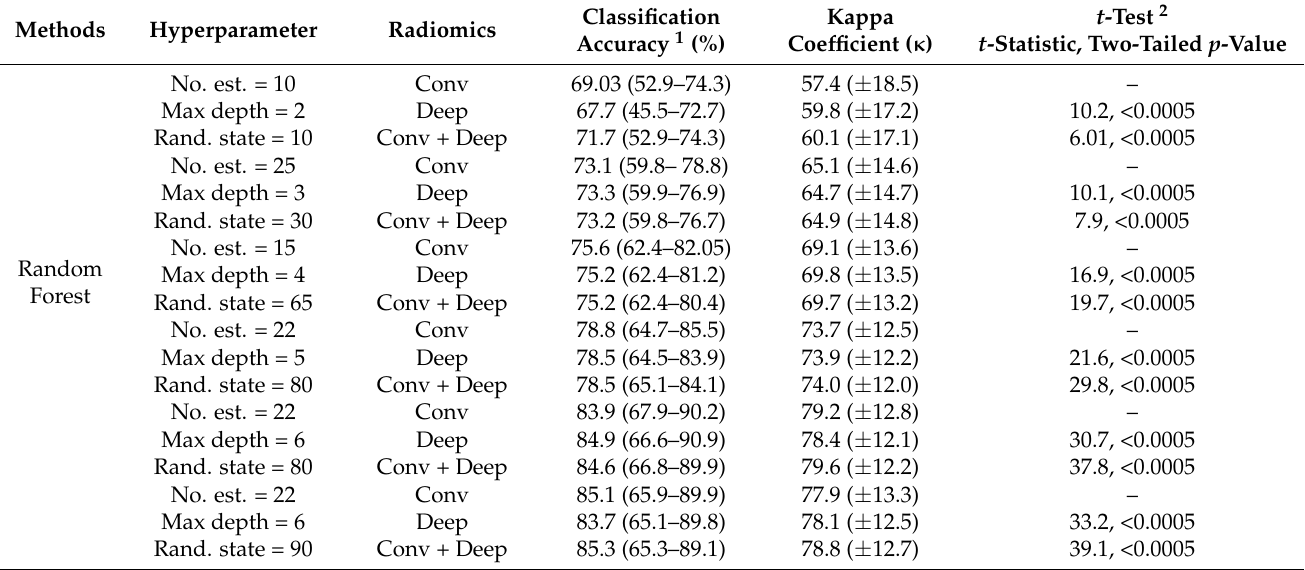
Table 2. Results of automated diagnosis of breast cancer in ultrasound imaging based on the classification of benign versus malignant patients with leave-one-out cross-validation. Convolutional and Deep learning radiomics are presented by conv and deep, respectively. Also, number of the trees (No. est.), maximum depth (Max. depth), and random state (Rand. state). Accuracy of Different Multivariate Models for Breast Cancer Diagnosis in Ultrasound